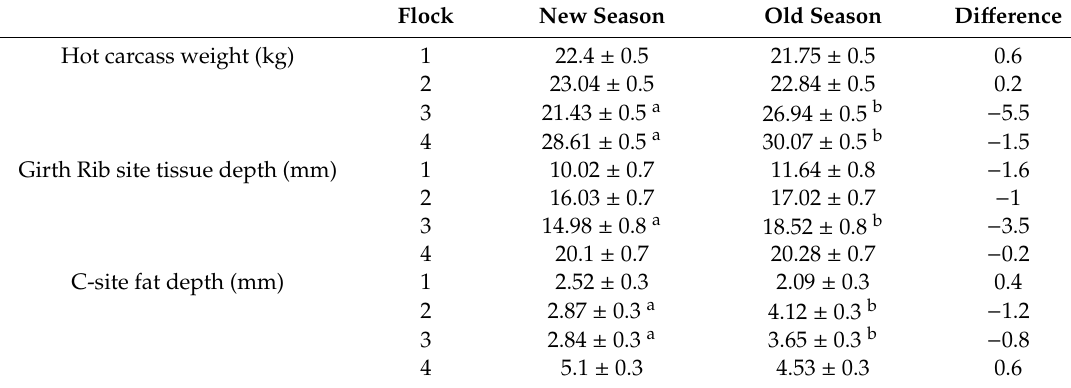
Table 5. Carcass characteristics, colour parameters and instrumental measures of new season and old season lambs from each flock (predicted means ± S.E.), and the di ff erences between new season and old season lambs for these